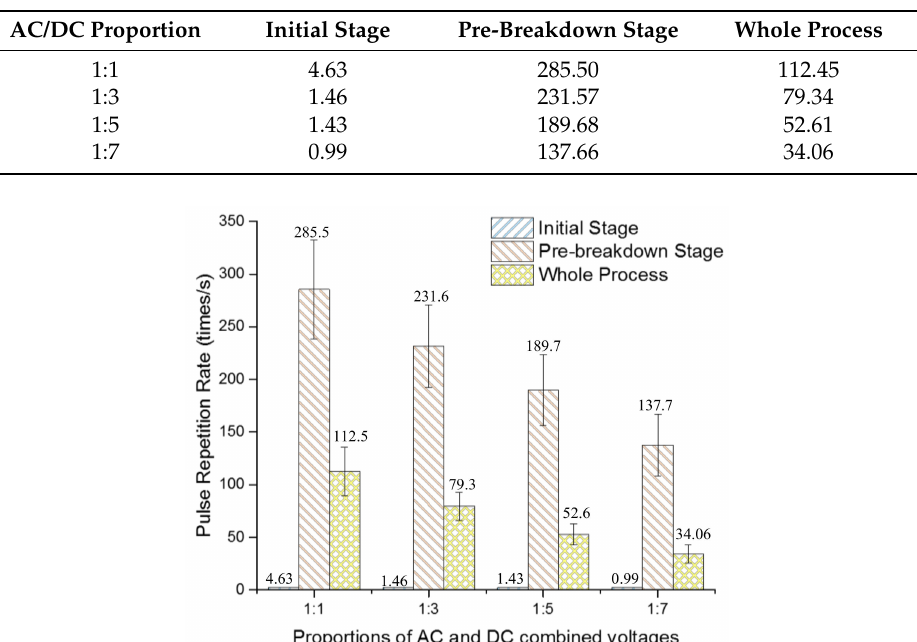
Table 2. Relationship between pulse repetition rate and AC/DC proportions.